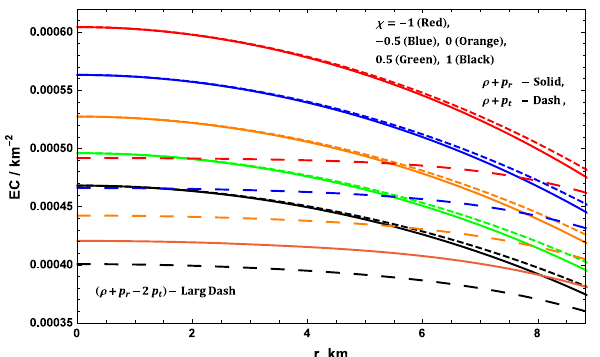
Fig. 7 Energy conditions of SMC X-4 for M = 1 . 29 M (cid:9) , R = 8 . 831 km and b = 0 . 0031km − 2